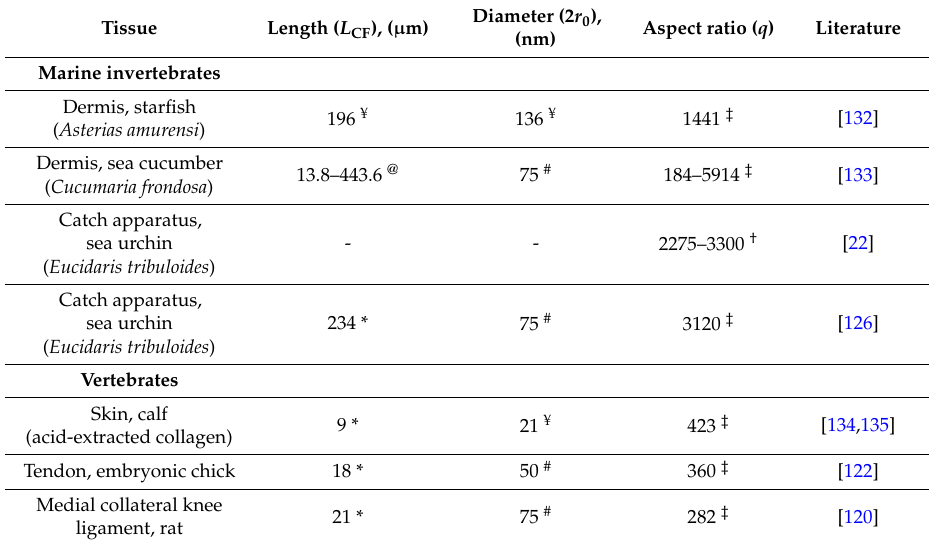
Table 2. Examples of the length, diameter and aspect ratio of collagen fibrils in marine invertebrates as well as land